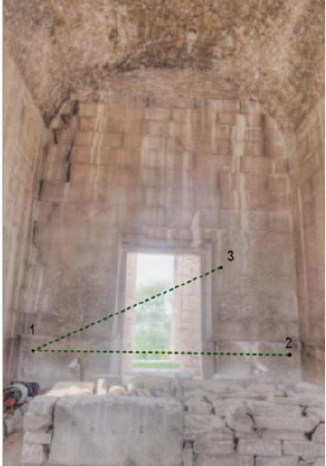
Figure 9 : The three geodetically measured points